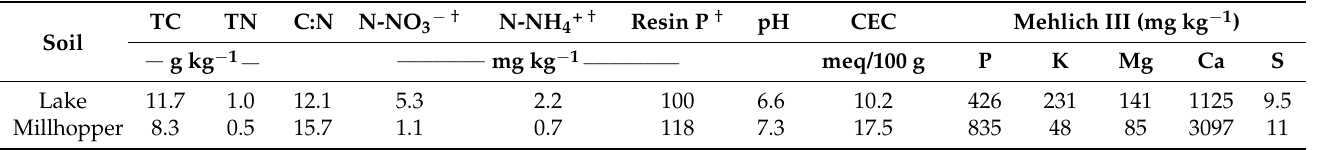
Table 2. Soil properties measured before the beginning of the study: total carbon (TC), total nitro- gen (TN), and C:N measured by combustion; nitrate nitrogen (N-NO 3 − ) and ammonium nitrogen (N-NH 4+ ) measured by 2M KCl extractions and colorimetry; soil pH (1:1 soil-to-water ratio); cation exchange capacity (CEC), phosphorus (P), potassium (K), magnesium (Mg), calcium (Ca), and sulfur (S) measured with Mehlich III extraction and inductively coupled plasma spectrometry. All mea- surements were conducted on one sample using air-died soil, except for those indicated as fresh soil ( † ).